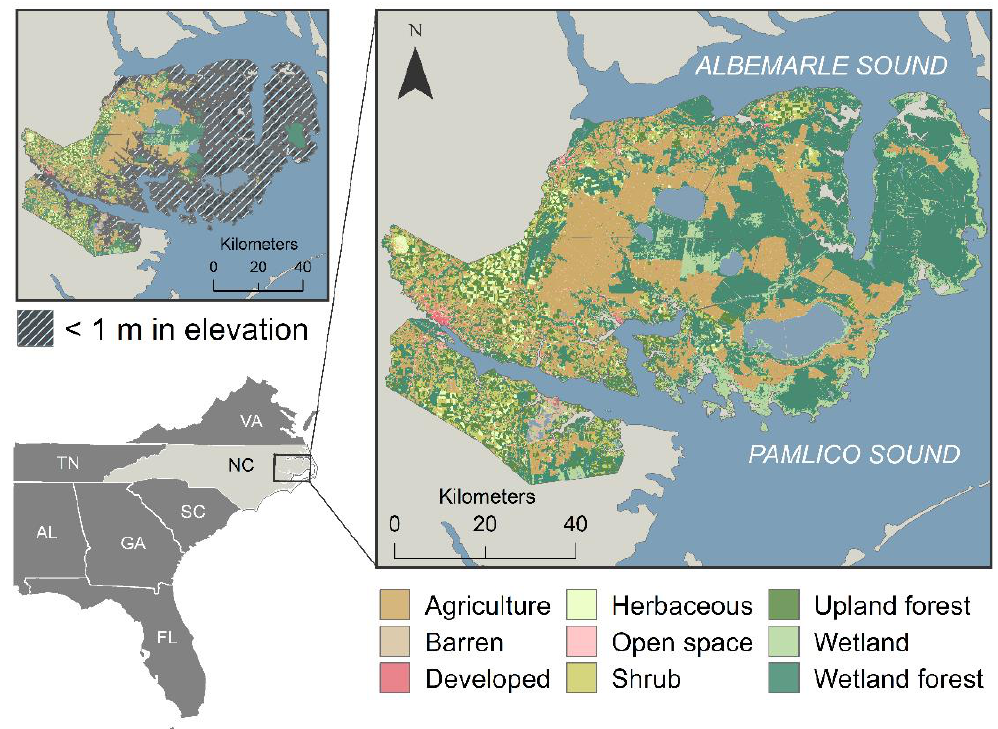
Figure 1. The Albemarle-Pamlico Peninsula is an approximately 4000 km 2 region in Eastern North Carolina, USA. It is bounded by the Albemarle and Pamlico Sounds, which are separated from the Atlantic Ocean by a chain of barrier islands. Almost half (47%) of the peninsula lies below 1 m in elevation exposing agricultural lands, forestry operations, and natural coastal forests to impacts from sea level